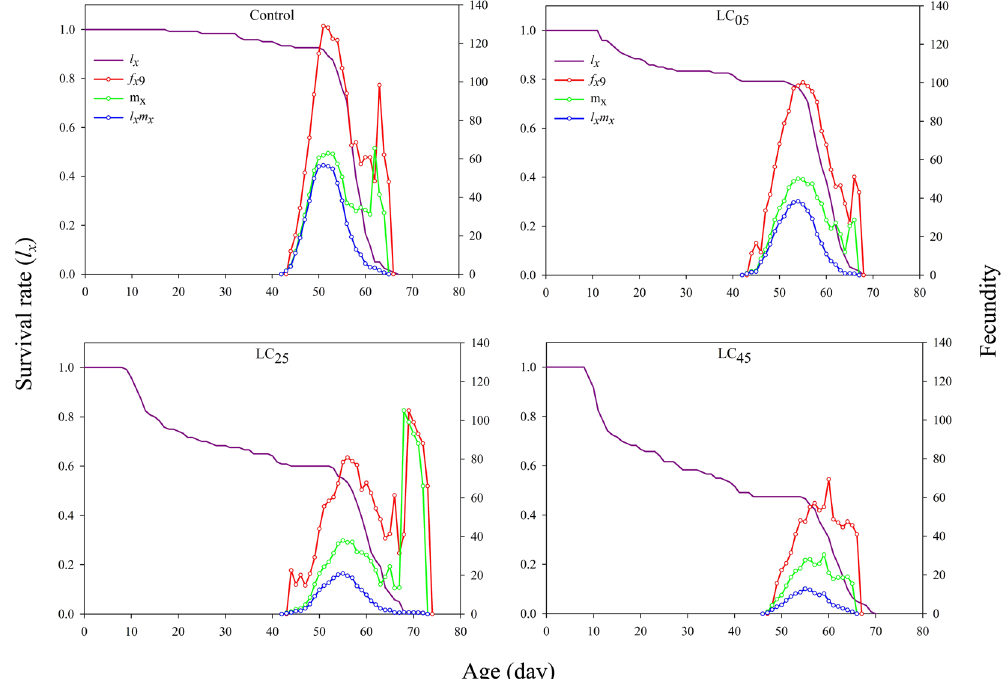
Figure 2. Age-specific survival rate ( l x ), female age-specific fecundity ( f x 9 ), age-specific fecundity of the total population ( m x ), and age-specific maternity ( l x m x ) of A. ipsilon after exposure to low-lethal concentrations of